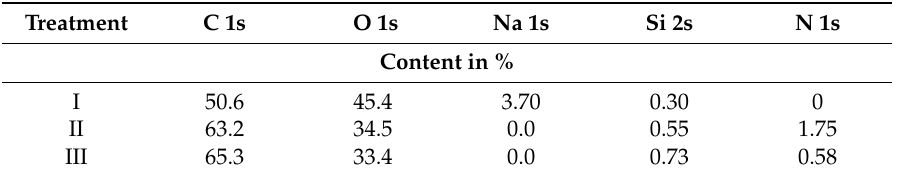
Table 1. Relative elemental composition of the carboxymethyl cellulose (CMC)-carbon nanotube (CNT) films for different post-treatments. The compositions were determined via X-ray photoelectron spectroscopy (XPS) and considering the relative sensitivity factors for the different peaks. The details for the treatments can be found in the main